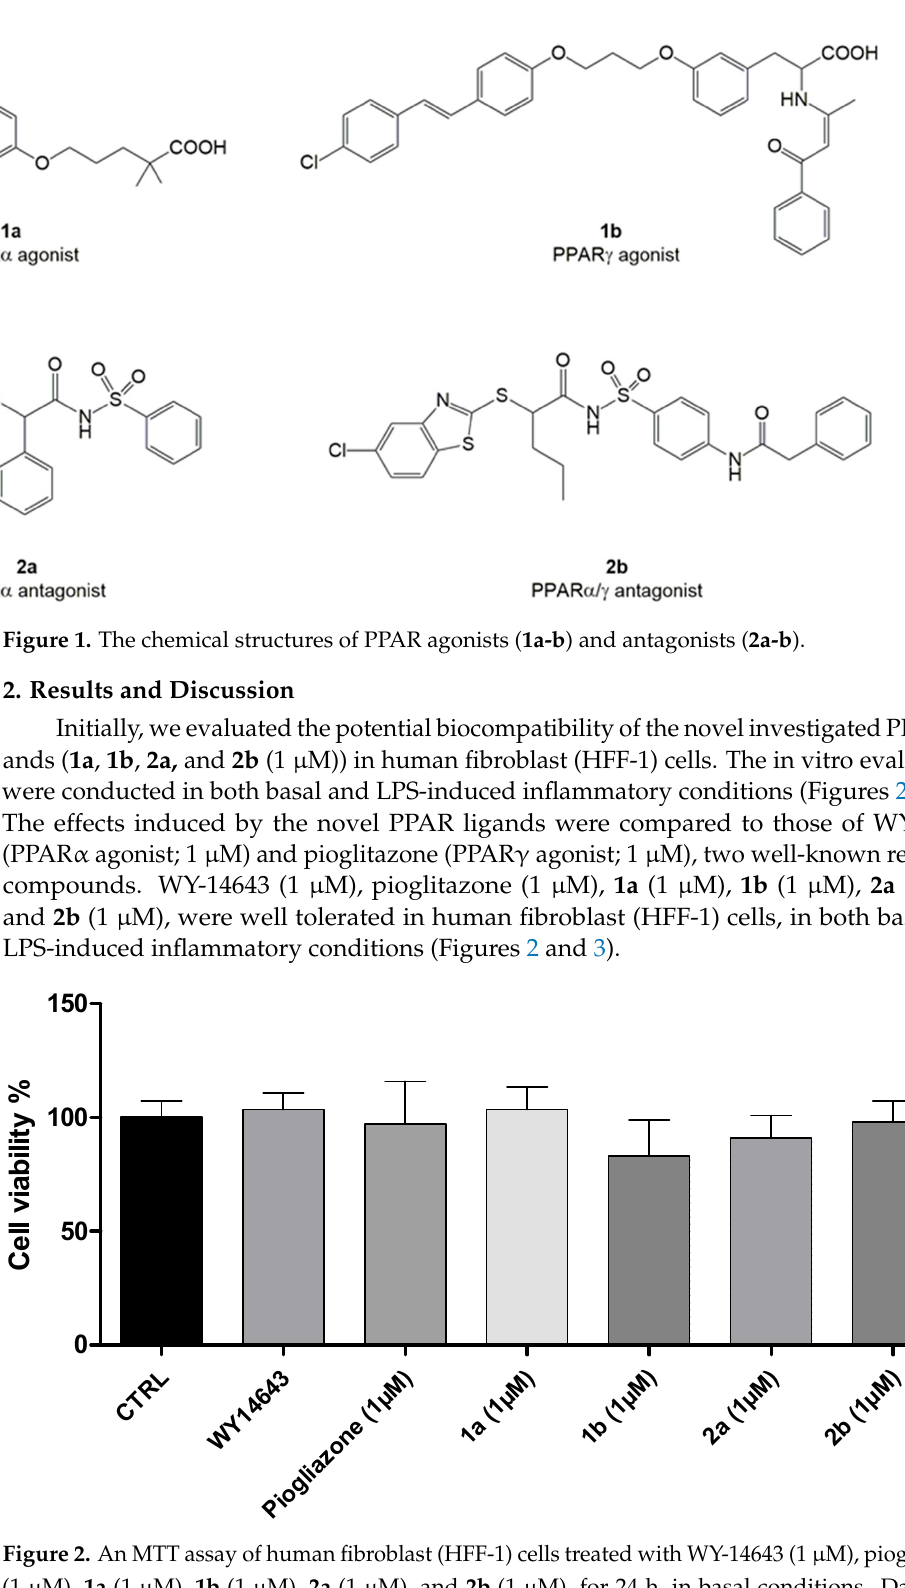
Figure 3. An MTT assay of LPS ‐ pretreated human fibroblast (HFF ‐ 1) cells, exposed to WY ‐ 14643 (1 μ M), pioglitazone (1 μ M), 1a (1 μ M), 1b (1 μ M), 2a (1 μ M), and 2b (1 μ M), for 24 h. Data were reported as means ± SEM. The results were analyzed by analysis of variance (ANOVA) followed by the Newman–Keuls post ‐ hoc test. ANOVA, p < 0.01; * p < 0.05 vs. CTRL.